Question: State the chart type depicted above.
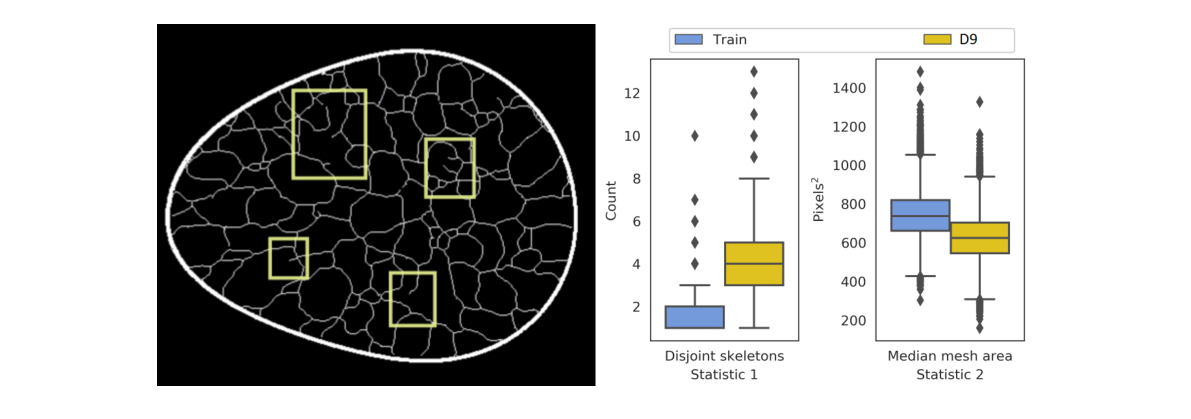
Answer: box